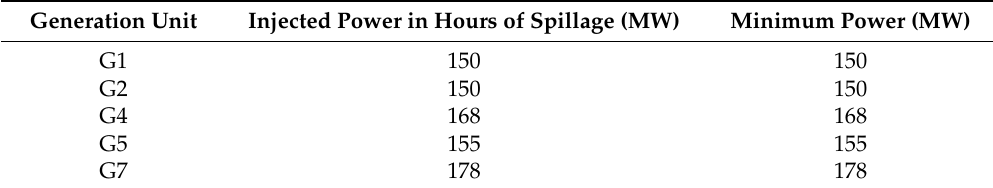
Table 4. Injected power by conventional units during hours of